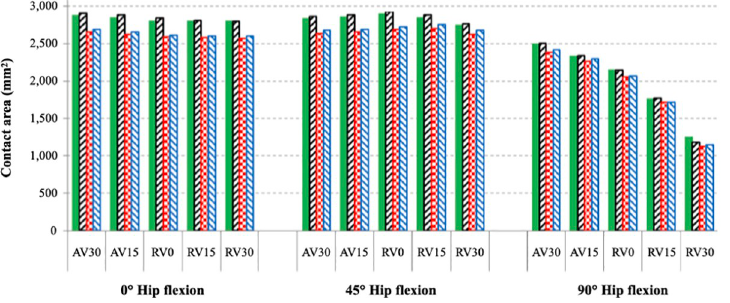
Fig 5. Contact area between the acetabular cup and head in different loading conditions and acetabular cup positions. Acetabular cup is position with 40˚ of inclination and 15˚ of version (green line); 40˚ of inclination and 25˚ of version (black line); 50˚ of inclination and 15˚ of version (red line); 50˚ of inclination and 25˚ of version (blue